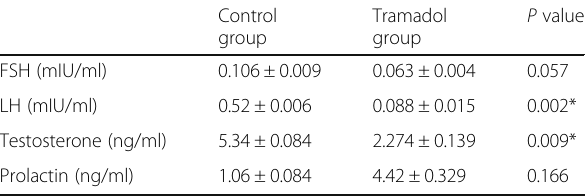
Table 1 Mean serum levels of FSH, LH, testosterone and prolactin in the control and tramadol groups